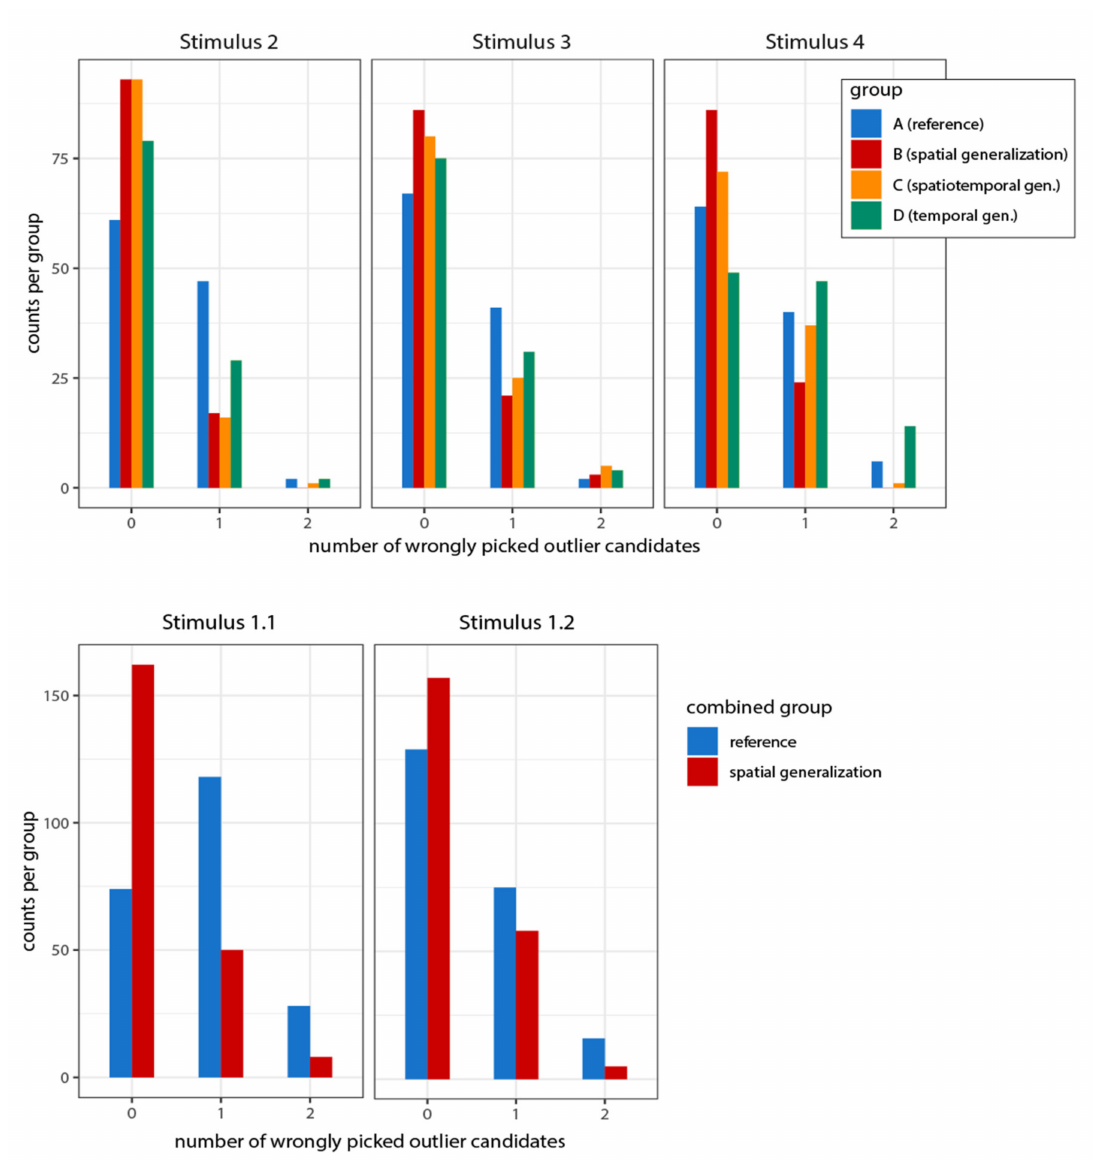
Figure 8. Number of persons per group/generalization type for erroneously picking none, one, or two wrong outlier candidates (“false